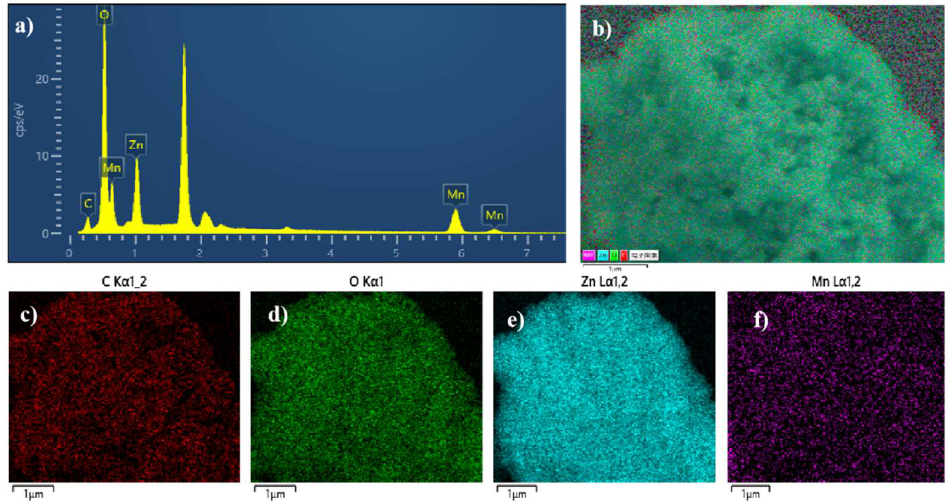
Figure 3. Total spectrum of ZnO‐C/MnO 2 distribution map ( a ), EDS layered image of ZnO‐C/MnO 2 ( b ), Element distribution image of C, O, Zn, Mn ( c – f ).